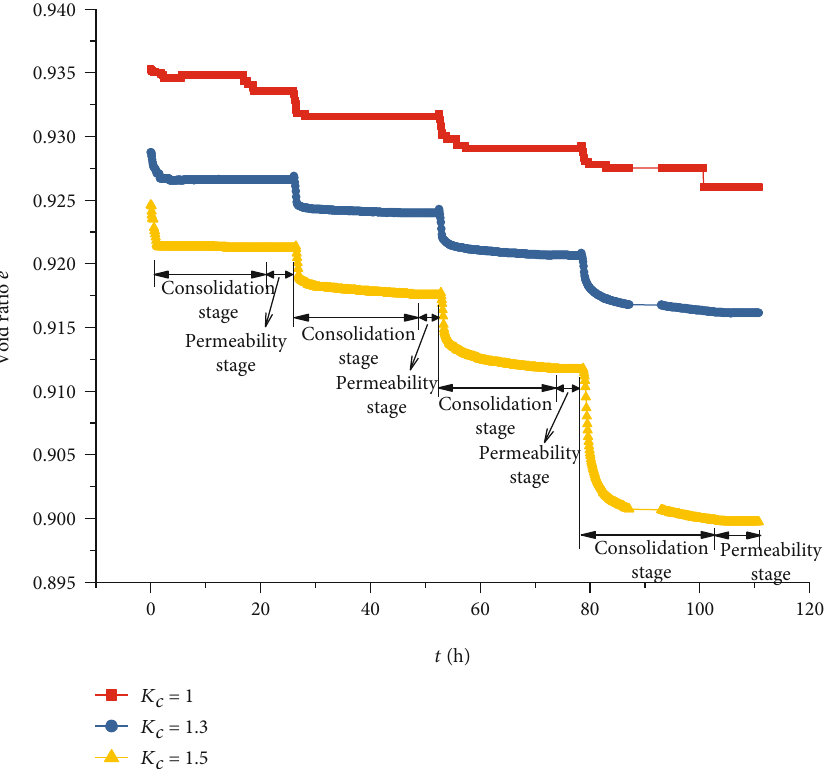
Figure 16: The curve of overconsolidation void ratio with time at di ff erent consolidation stress ratios. Table 9: Stress calculations of overconsolidation clay. Stress